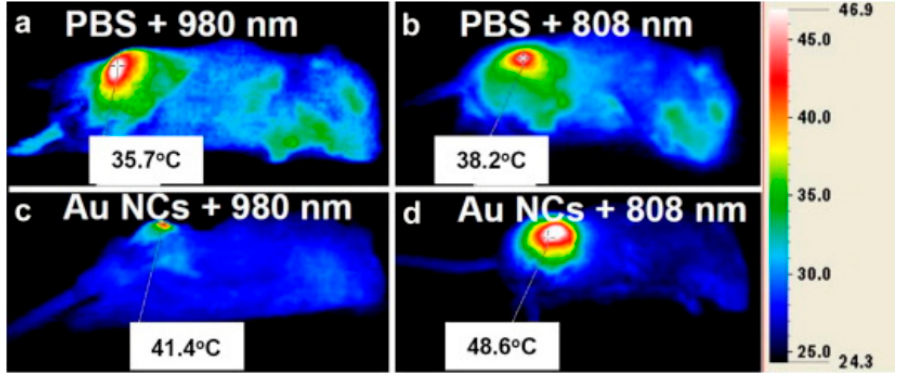
Figure 2. In vivo photothermal images of mice treated with phosphate buffer solution (PBS) and Au nanoparticles under 808, 915 and 980 nm laser (150 mW/cm 2 power) (Reproduced with permission [110]).